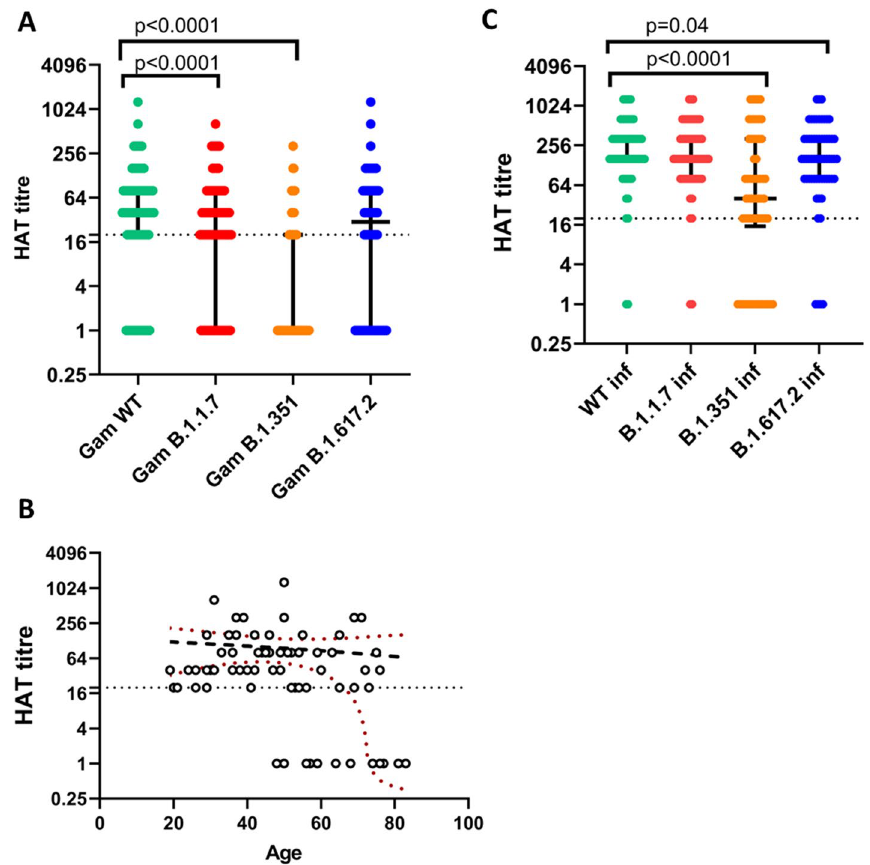
Figure 2. Antibodies to the RBD of SARS-CoV-2 Ancestral Wuhan (WT) virus and the variants of concern by the haemagglutination test (HAT). Antibodies to the RBD were measured by HAT in previously uninfected individuals at 4 weeks following a single dose of Gam-COVID-Vac (n = 69) for the WT, B.1.1.7, B.351.1 and B.1.617.2 ( A ) and in previously infected individuals (n = 62), at 4 weeks to WT, B.1.1.7, B.1.351 and B.1.617.2 ( B ). The age was correlated with the HAT titres for the WT (Spearman’s r = −0.26, p = 0.03). Wilcoxon matched pairs signed ranked test was used to find out the differences in HAT titres in baseline uninfected and infected individuals for WT and the VOCs. All tests were two sided. The error bars indicate the median and the interquartile